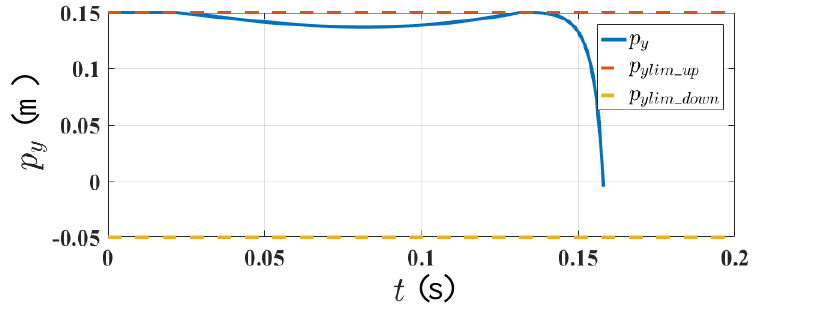
Figure 11. Assuming that X 0 = ( − 57 ◦ , 158 ◦ , − 126 ◦ , 0, 0, 0 ) , the ZMP is limited by the ZMP constraint to maintain balance throughout the push-off